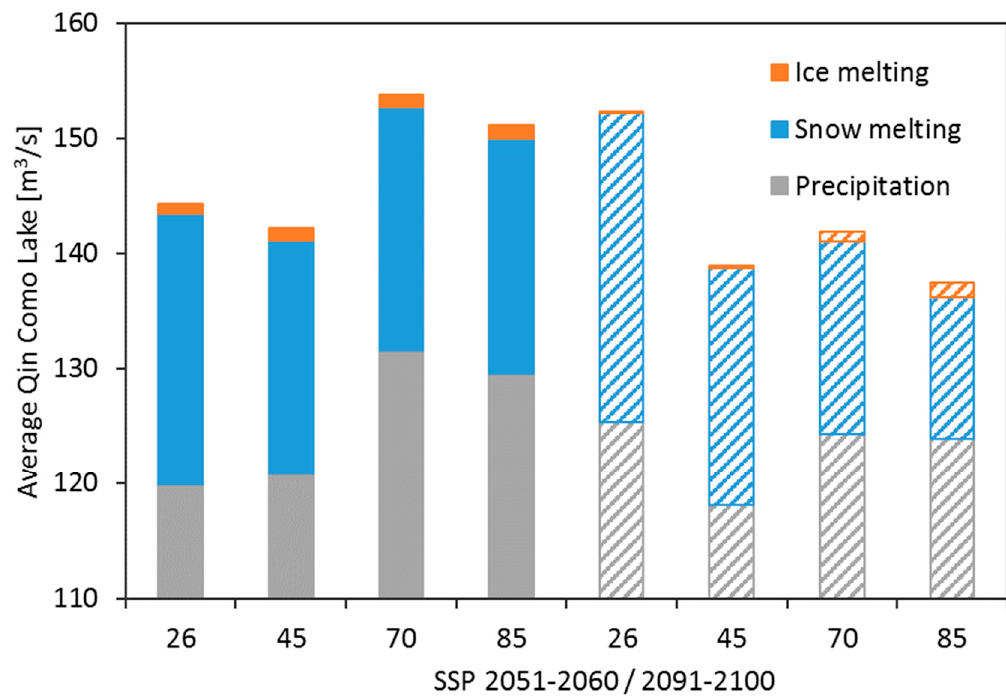
Figure 12. Projected share of flow components for each SSP, and average inflow at Coo lake Q y for each SSP (average among models), at half century (solid) and end of century (striped).